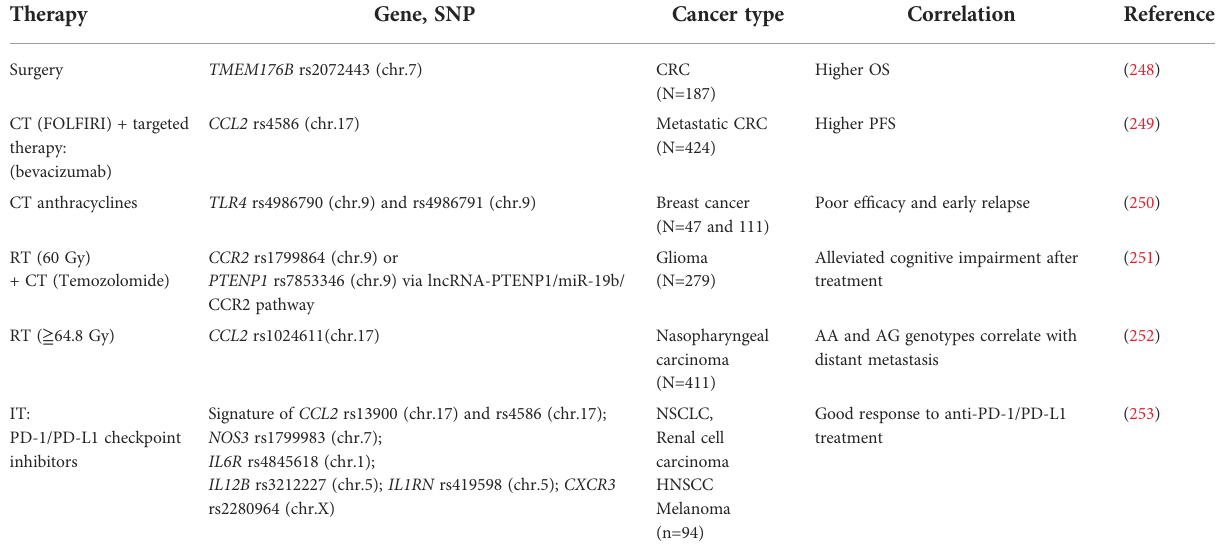
TABLE 3 Monocyte SNP association with anti-cancer therapy effects.